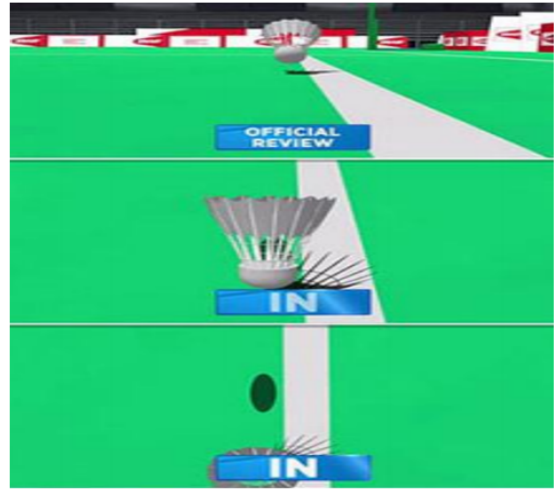
Figure 21. Exact spot on which the shuttlecock